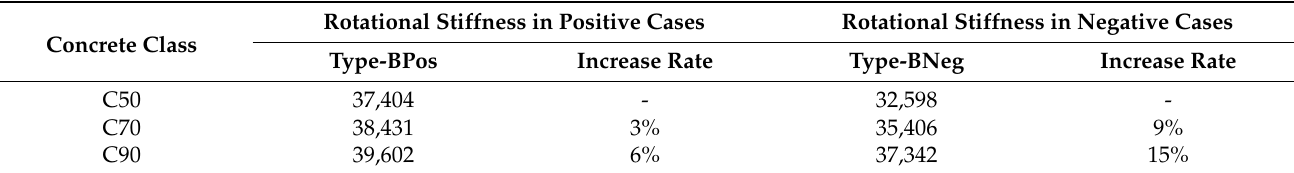
Figure 24. Evolution of the rotations and bolt stresses with different concrete classes: ( a ) rotation curves; ( b ) bolt stress curves. Table 9. Summary of the rotational stiffnesses during the third stage with different concrete classes (stiffness unit: kN·m/m/rad, modulus unit: GPa).